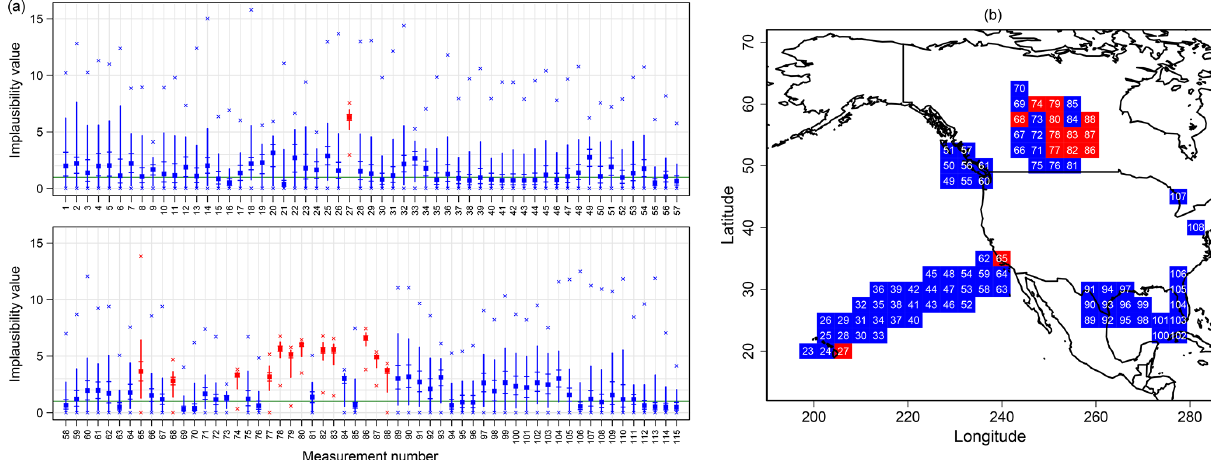
Figure 4. (a) The distribution of implausibility calculated over the 1 million model variants for each measurement in the July N 50 concen- tration set, shown vertically. For each measurement, numbered along the x axis, the range of the implausibility distribution is shown by the outer crosses, the bar corresponds to the 95% credible interval (2.5% to 97.5% empirical quantiles), the horizontal markers through the bar show the interquartile range, and the square point is the median implausibility. Here, we assume no structural error term in the implausibility calculations and use the implausibility distribution to identify potential structural errors. Measurements coloured red are ruled out as poten- tial structural error cases (as the lower 95% credible interval bound is > 1), and those coloured blue are retained and used in our constraint procedure. (b) Corresponding map to show the locations of the rejected July N 50 measurements (red) and those retained for constraint (blue), over the North Pacific and North American region (outside this region, all measurements were retained). We hypothesise that the red points over the Pacific correspond to ports with localised pollution sources, while the red points over Canada correspond to localised fire emissions that are not represented at the resolution of the